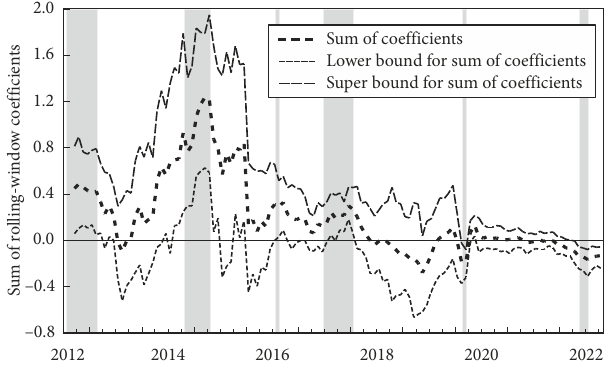
Figure 3. The coefficients of the influence from GSCP to BP (source: authors’